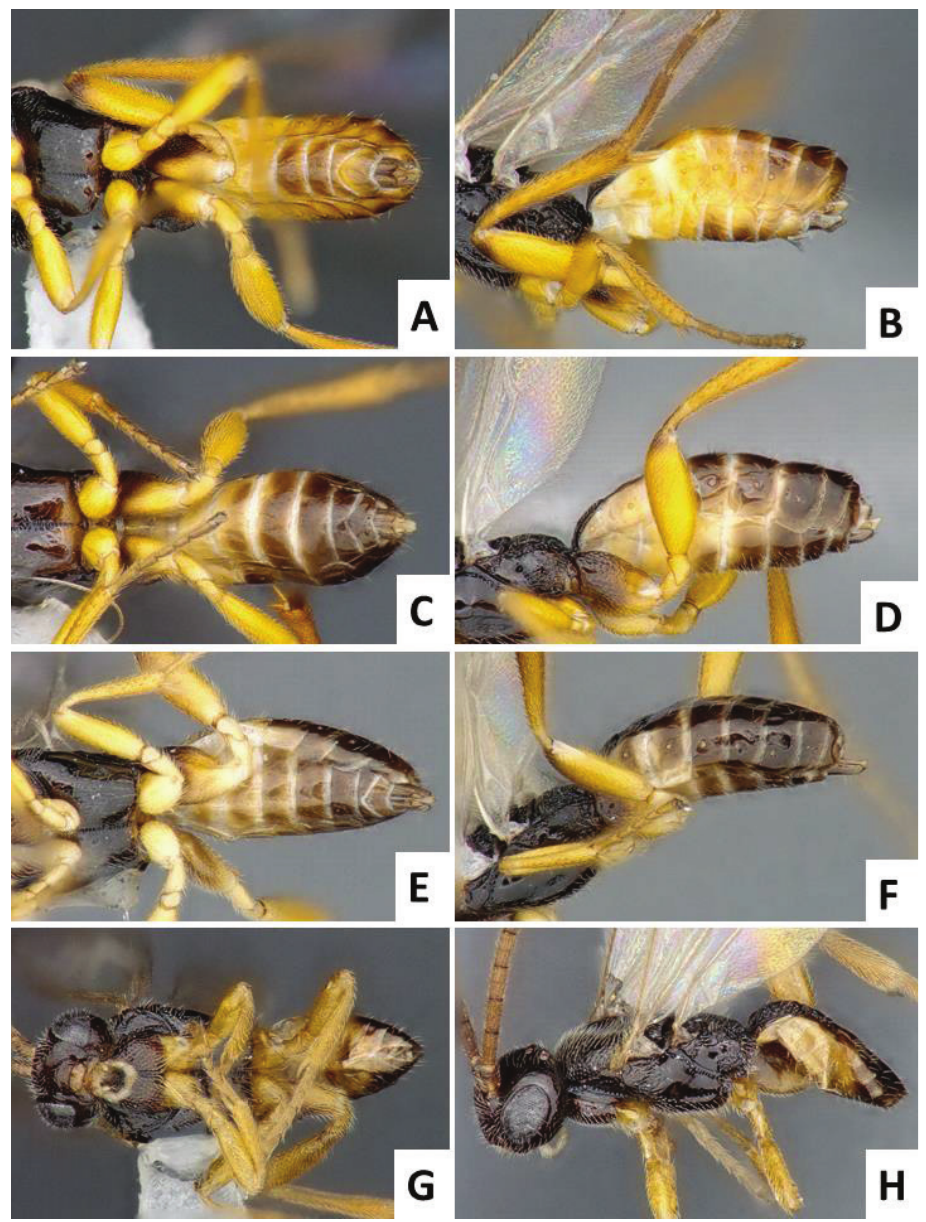
Figure 3. Male metasoma in ventral and lateral view. A, B Cotesia typhae , paratype specimen from Kenya C, D Cotesia sesamiae , specimen from Kenya E, F Cotesia flavipes , specimen from Kenya G, H Cotesia chilonis , specimen from